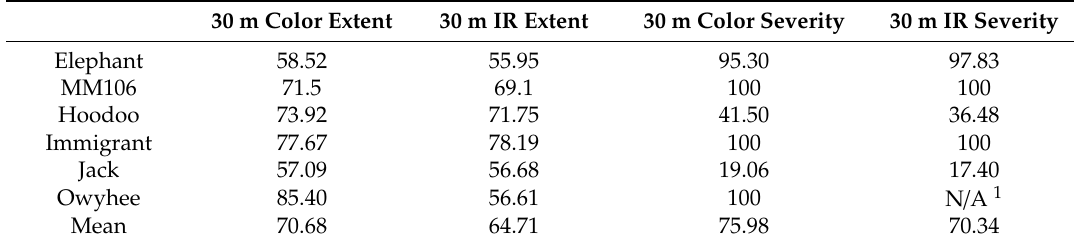
Table 2. Color Experiment vs. IR